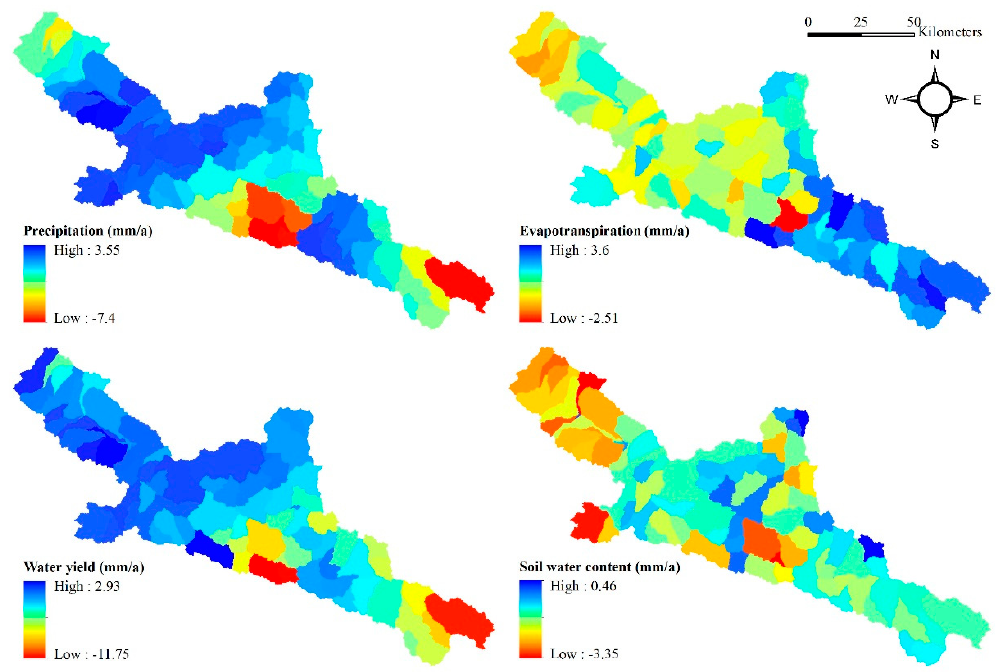
Figure 14. Change trend of the water balance components at the sub-basin scale from 2003 to 2014.